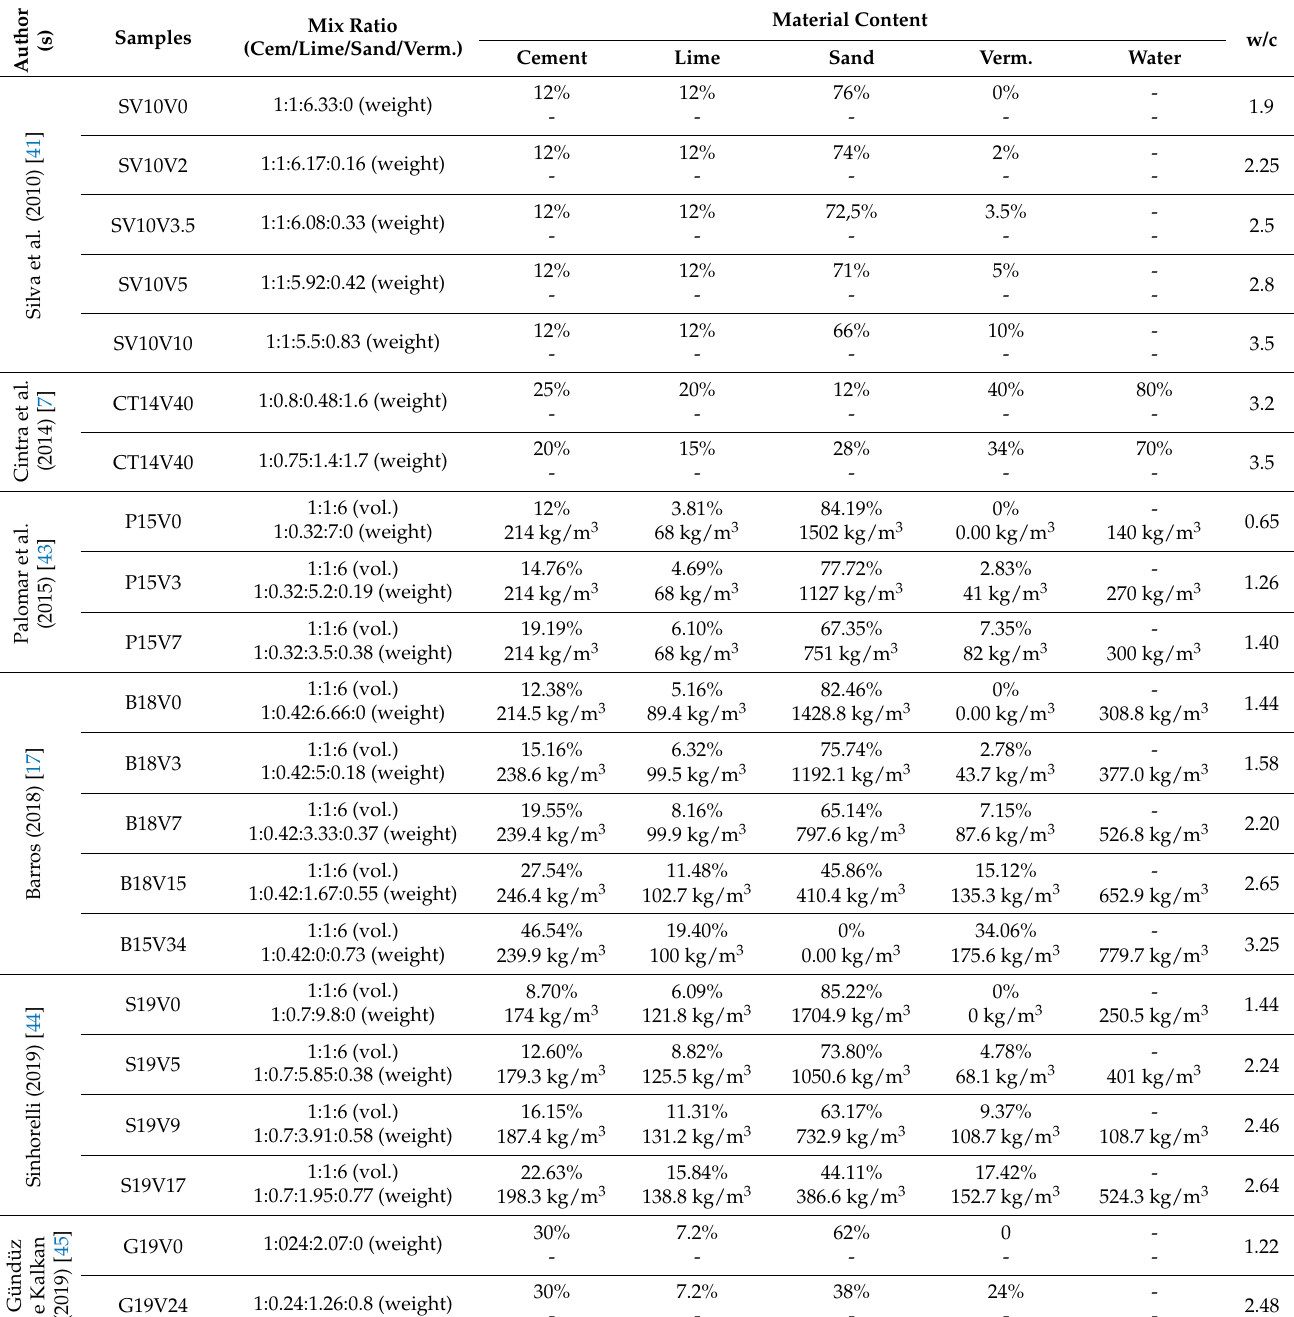
Table 5. Mix designs’ compositions